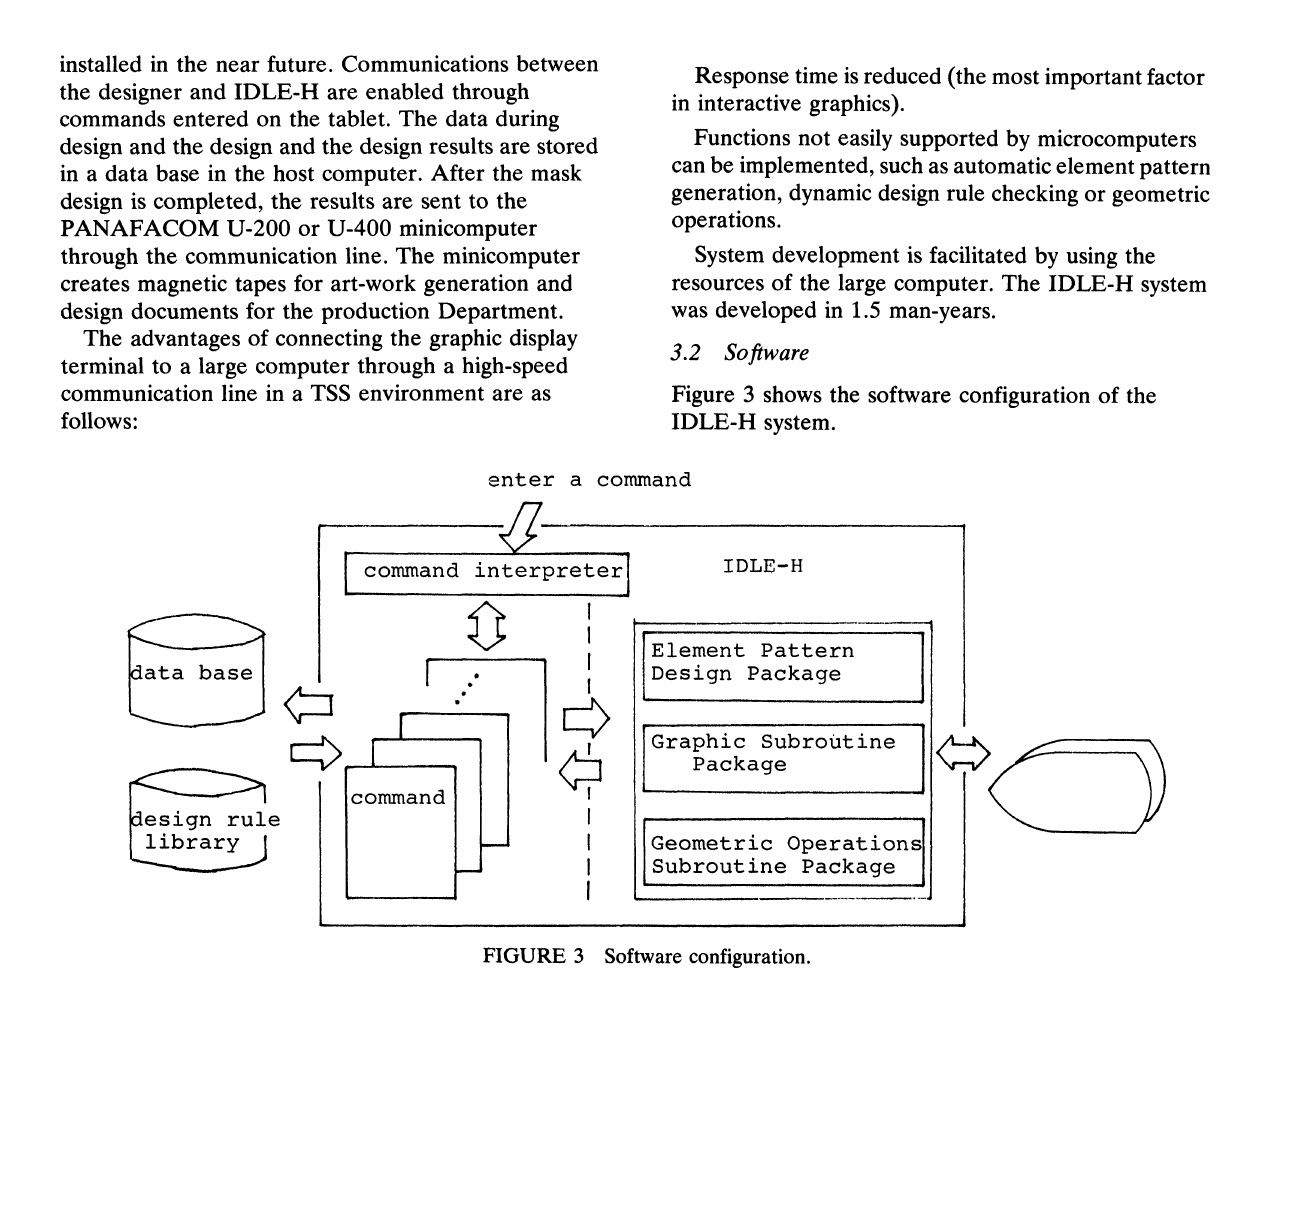
FIGURE 2 Hardware configuration.